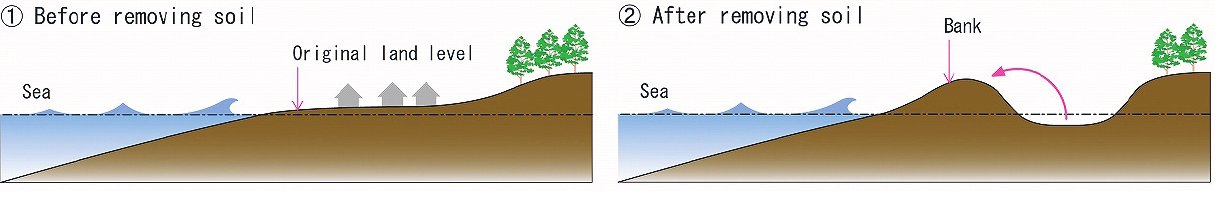
Figure 6. Original coastal area and the coastal area after removing soil.